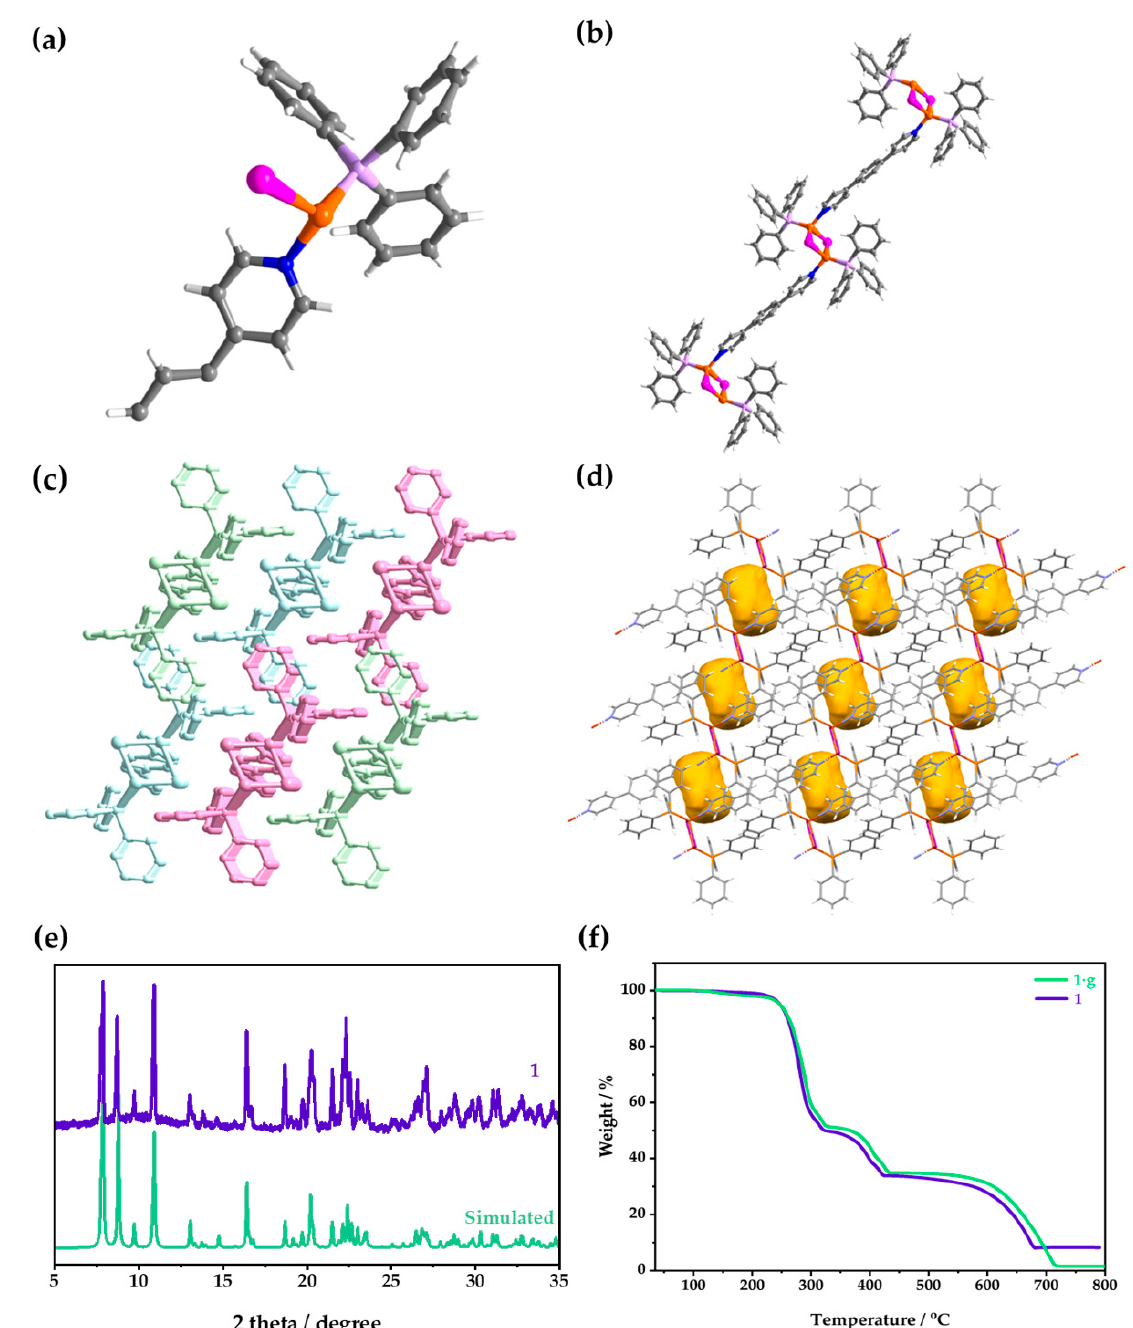
Figure 2. ( a ) The asymmetric unit, ( b ) chain structure, ( c ) 3D supramolecular structure, and ( d ) channels in the activated structure of 1 . Color codes for ( a , b , d ): C, gray; H, white; N, blue; P, lavender; Cu, orange; I, pink; Channels, yellow. For ( c ), different colors are employed to distinguish separate chains, and hydrogen atoms are omitted for clarity. ( e ) The PXRD patterns of 1 and ( f ) TG curves of 1 and 1 · g .